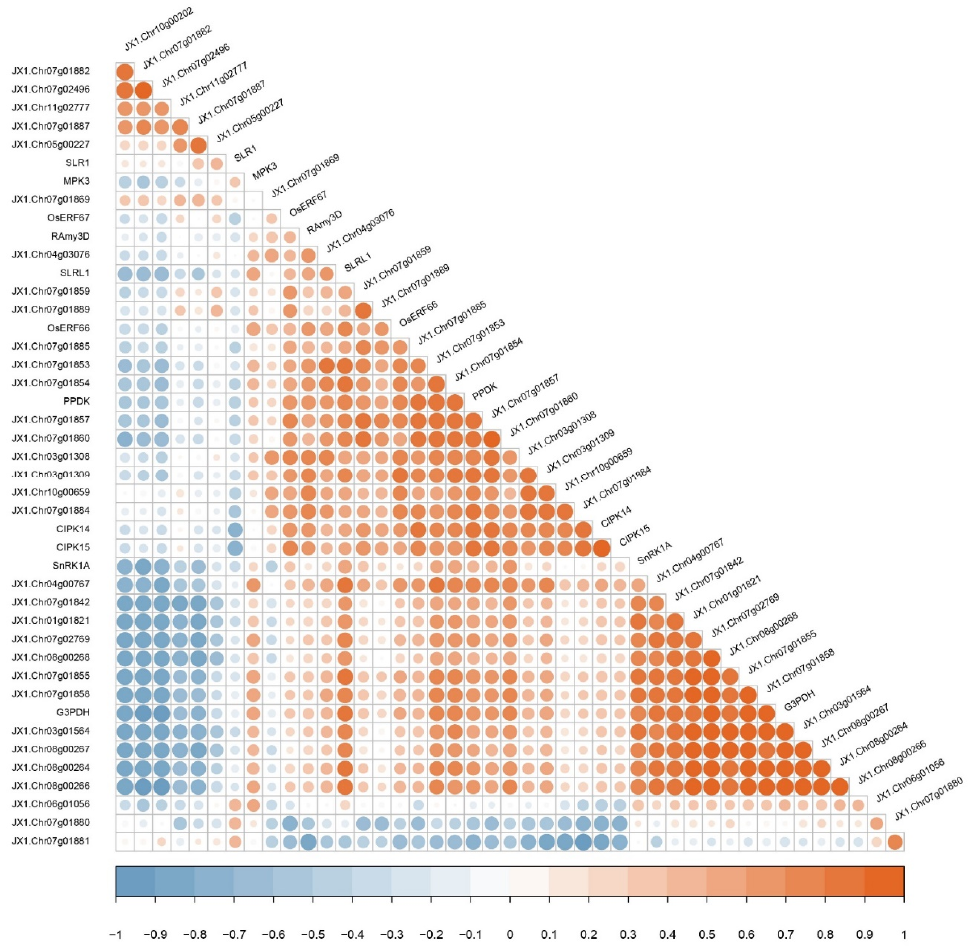
Figure 5. The correlation analysis of the DUF26 domain-containing genes and submergence tolerance genes in